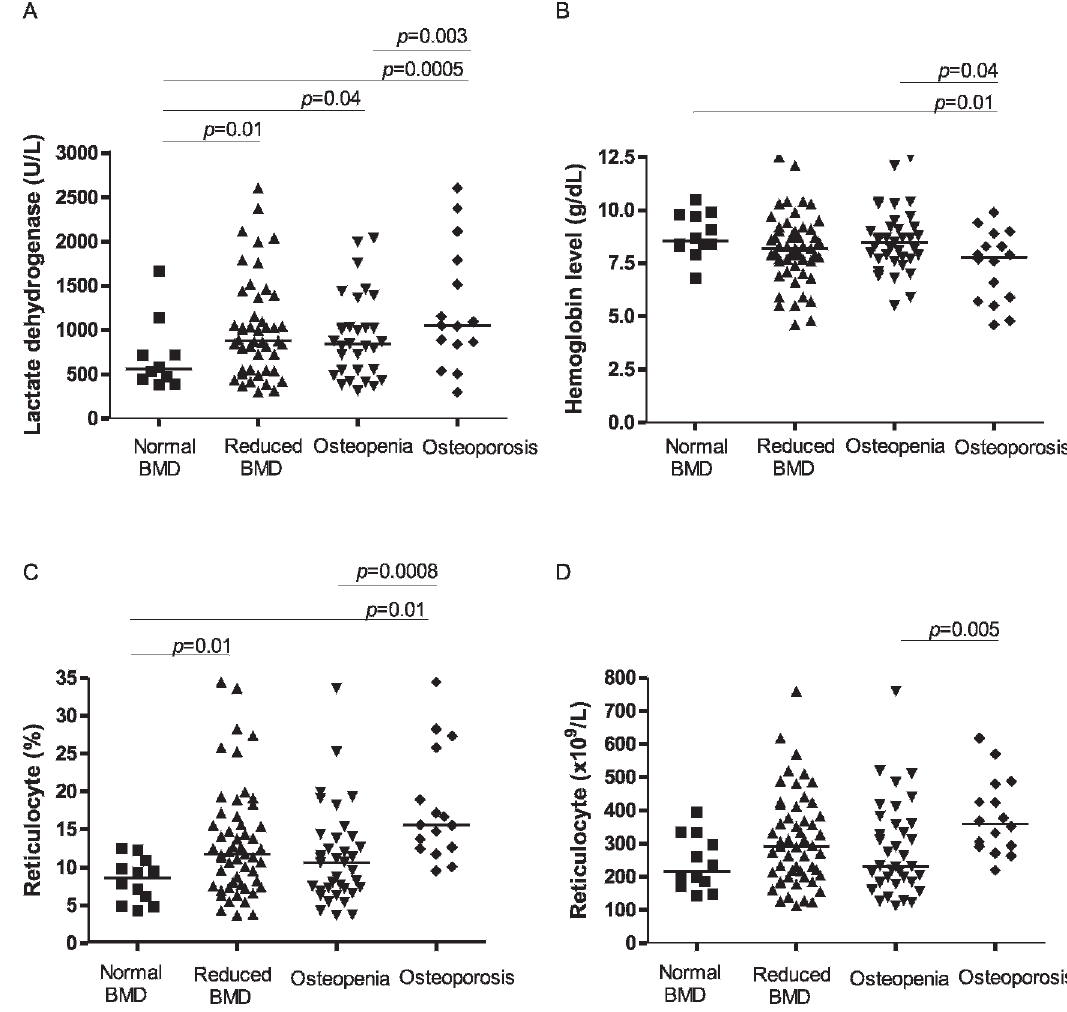
Figure 1 - (A) Lactate dehydrogenase levels (LDH); (B) Hemoglobin (Hb) values; (C) Percentage of reticulocytes and (D) Absolute reticulocyte counts in patients with normal bone mass density (BMD), reduced BMD (both osteopenia and osteoporosis), osteopenia alone and osteoporosis alone, as indicated in the figure. The horizontal bars indicate the median. The p -values are indicated in the